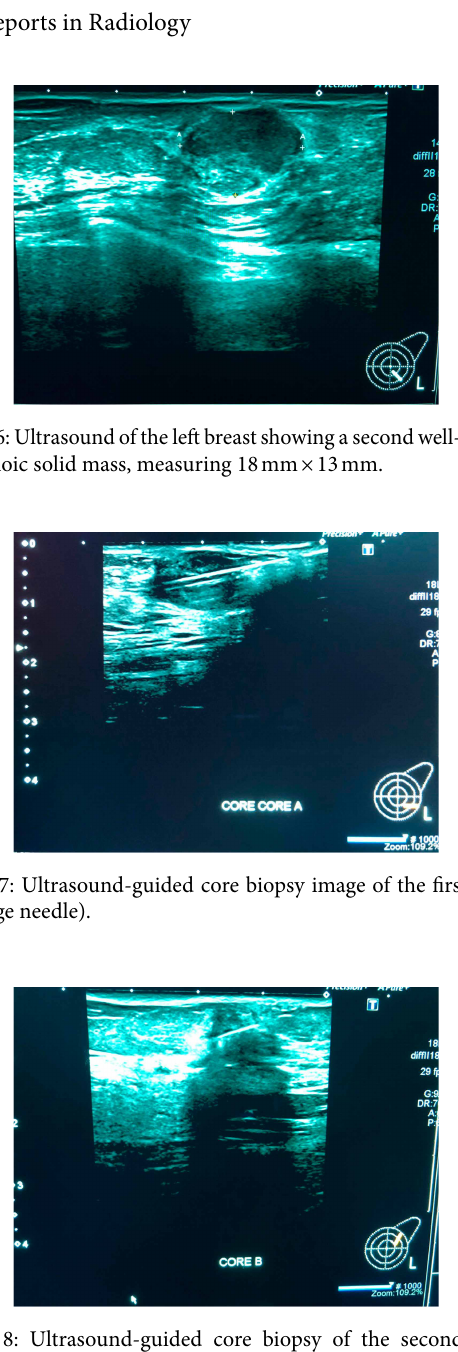
Figure 8: Ultrasound-guided core biopsy of the second lesion (14-gauge needle).